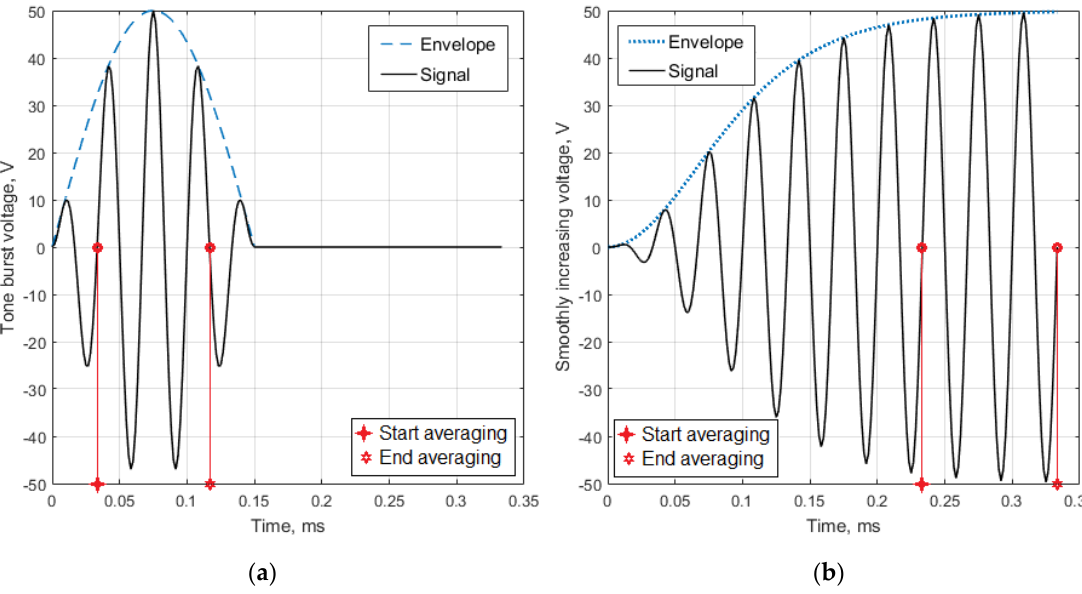
Figure 4. Two kinds of the actuator’s driving signals used for determination of the generated wave speeds and of the actuator’s directivity: ( a ) tone burst signal; ( b ) signal with a smooth increase and stabilization of the amplitude. Both signals have the carrying frequency 30 kHz.